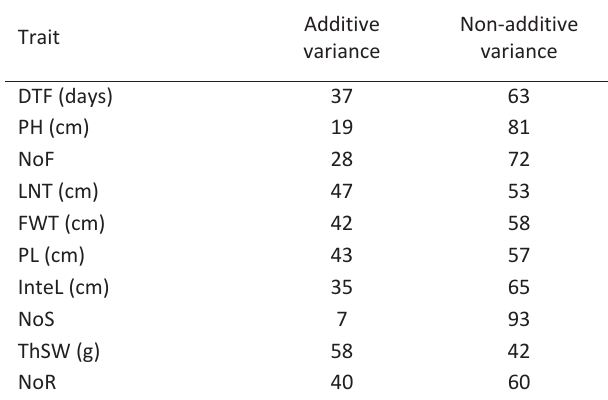
DTF= days to 50% flowering; PH= plant height at maturity; NOF= number of fruits per plot; LNT= fruit length; FWT= fruit circum­ ference; PL= Pedicel length; INL= internodal length; NOS= number of seeds per pod; THS= 1000­seed weight; NOR= num­ ber of ridges per pod.